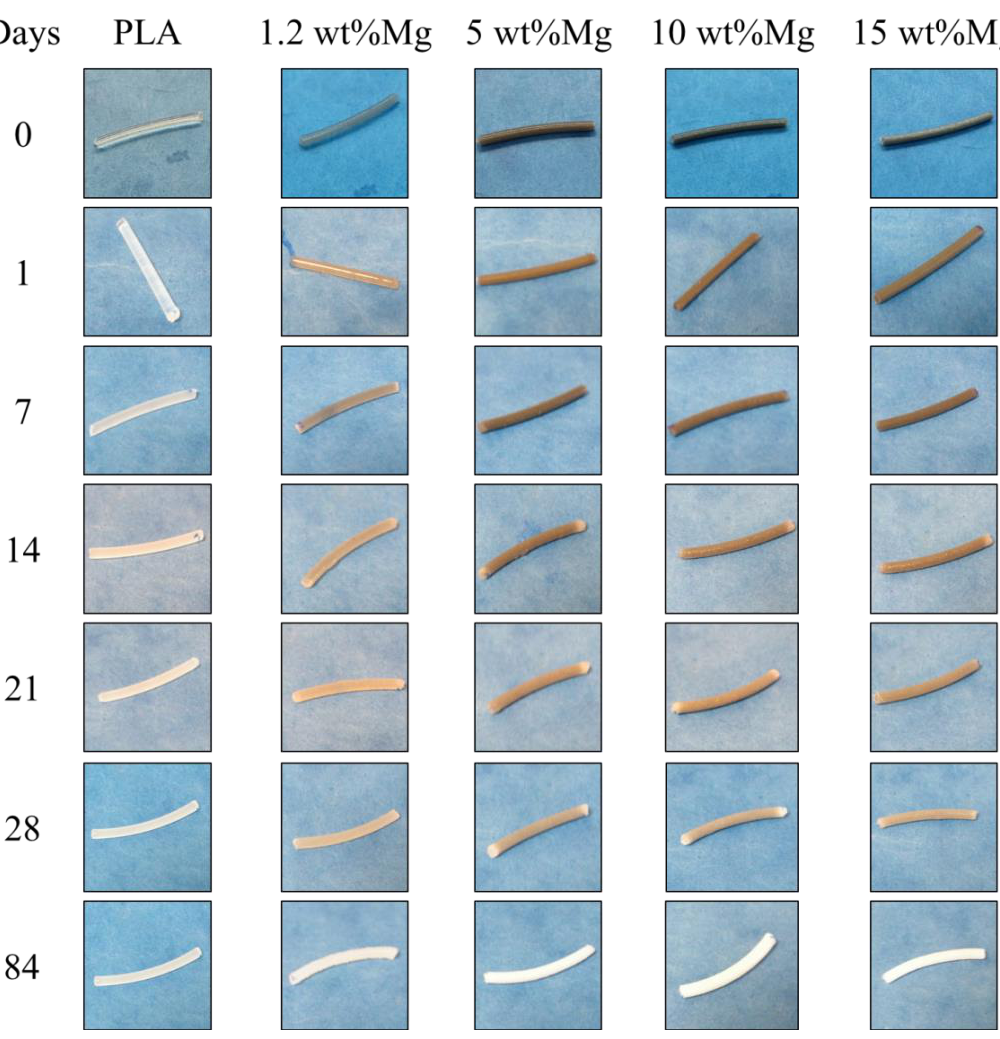
Figure 7. Visual appearance evolution of each PLA-Mg filament at different times. Initially at T0, the filaments’ color changed as the amount of Mg increased. In par- ticular, from a white transparent color for neat PLA to soft gray for 1.2 wt% Mg and dark gray for 5, 10, and 15 wt% Mg. As the degradation time increased, a loss of gray color was observed attributed to the release of Mg microparticles, which is in agreement with